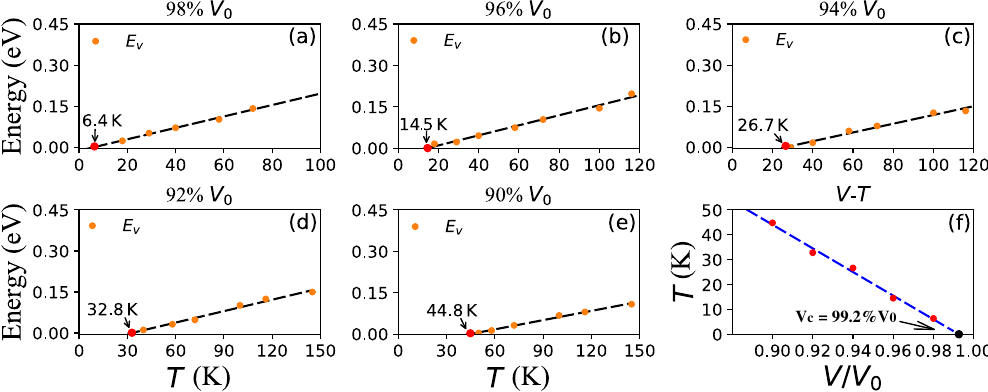
Fig. 3 Temperature and pressure dependence of valence band edge. a – e Temperature evolution of valence band edge E v at 98%, 96%, 94%, 92%, and 90% of the equilibrium volume V 0 , respectively. The tops of the valence bands relative to the Fermi level are marked as blue (orange) dots. The gray dashed lines are linear fi ttings to E v . The black arrow indicates the extrapolated critical temperatures T 1 (marked as red dots) when the E v cuts the Fermi level. f Pressure evolution of T 1 . The red dots mark T 1 from ( a – e ). The blue dashed line is the linear extrapolation to zero